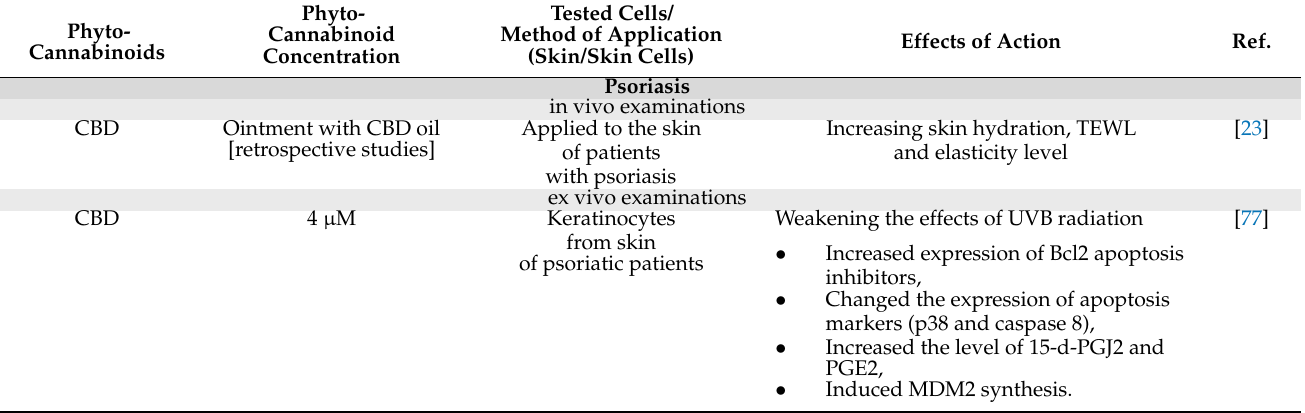
Table 2. The influence of phytocannabinoids on metabolic changes in skin cells and on skin function disorders resulting from skin